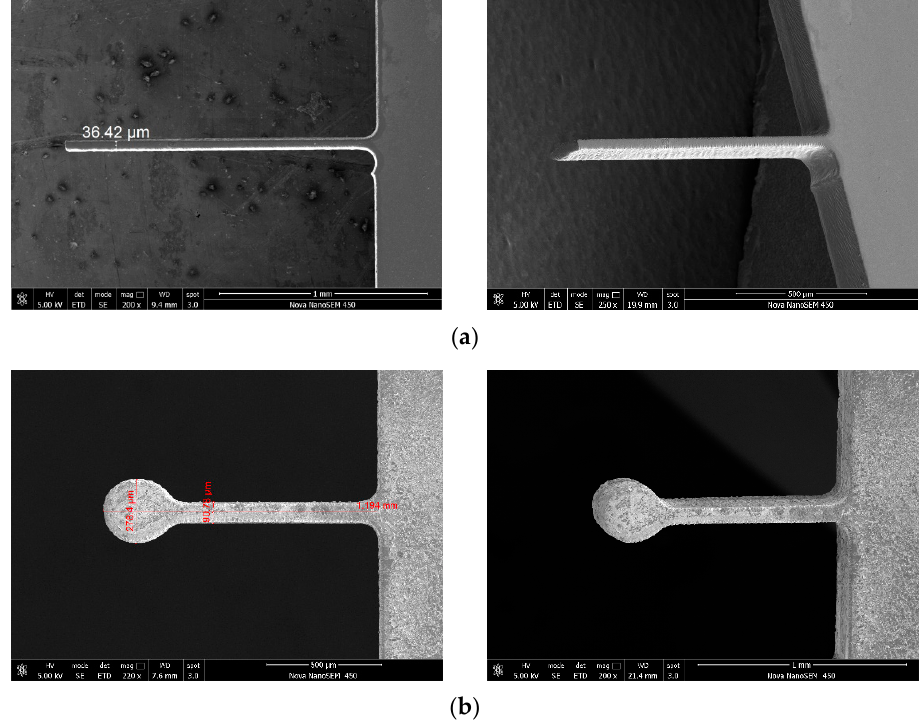
Figure 15. Micro planar coil structure and entrance slit width. ( a ) Front view; ( b ) Enlarged view of spiral part; ( c ) Enlarged view of entrance; ( d ) Rear view.